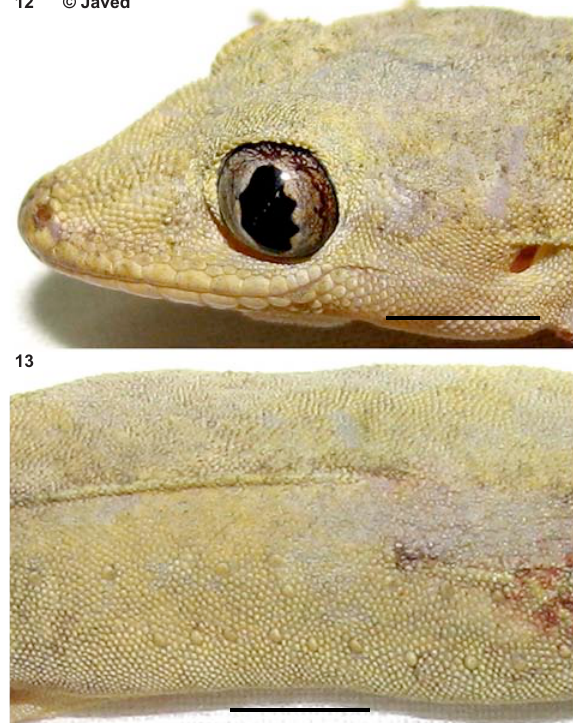
Image 12 & 13. (Scale 5mm) Image 12 & 13. Hemidactylus cf. frenatus male (ZSI/ 12. Dorsolateral aspect, Hemidactylus cf. frenatus male (ZSI/FBRC/V-1521) (live) head region FBRC/V-1521) (live). 12 - Dorsolateral aspect, head region showing eye, ear opening and labials. showing eye, ear opening and labials; 13 - Dorsolateral 13. Dorsolateral aspect, Hemidactylus cf. frenatus male (ZSI/FBRC/V-1521) (live) trunk region aspect, trunk region showing round scales. (Scale = 5mm) showing round scales.